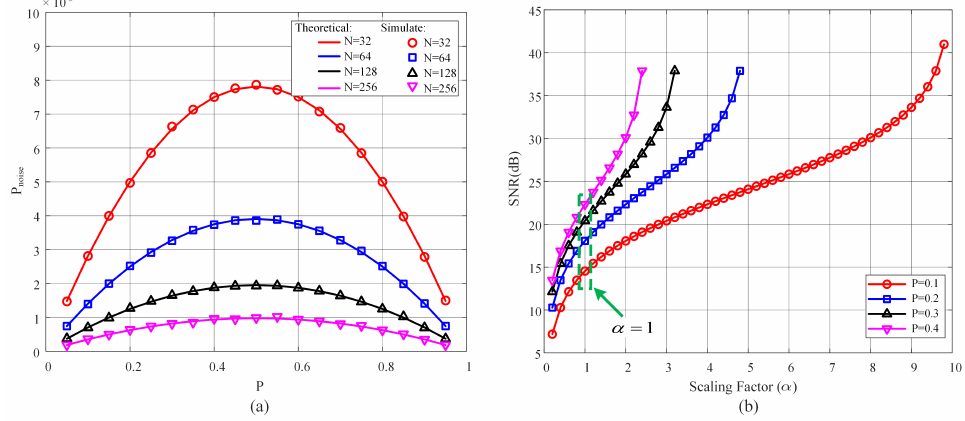
Figure 4. ( a ) MSE performance of stochastic bit stream representation with different bit stream length. ( b ) SNR performance of the stochastic bit stream representation for P = 0.1,0.2,0.3,0.4 with scaling as (8).